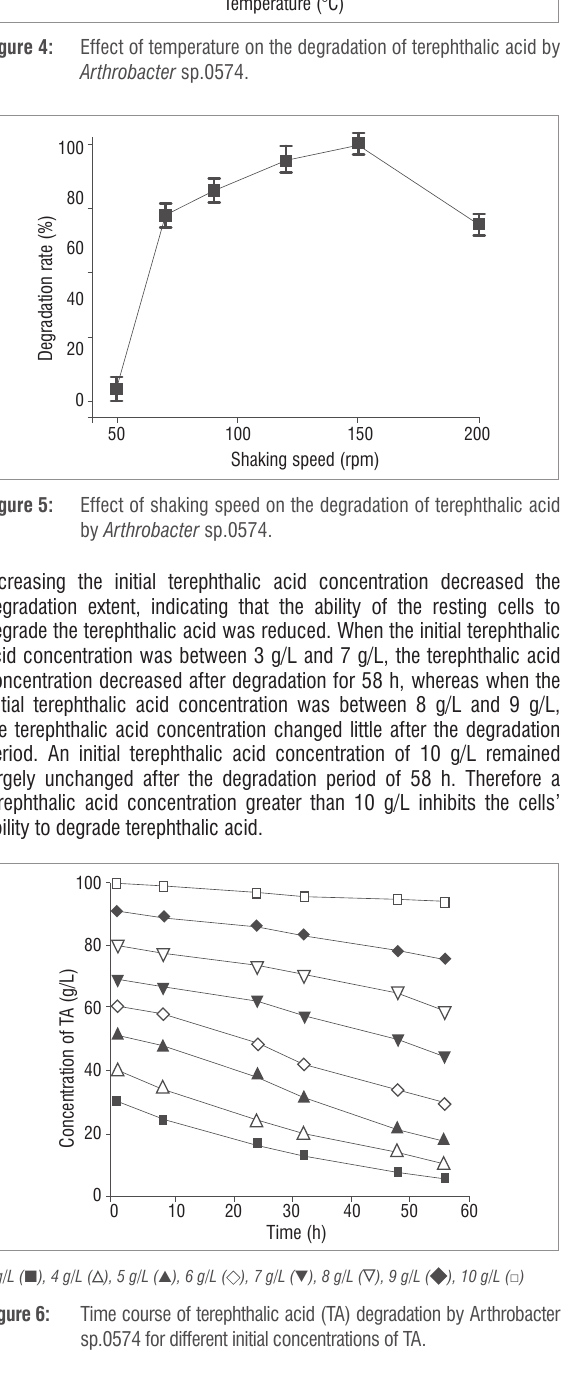
July/August 2013